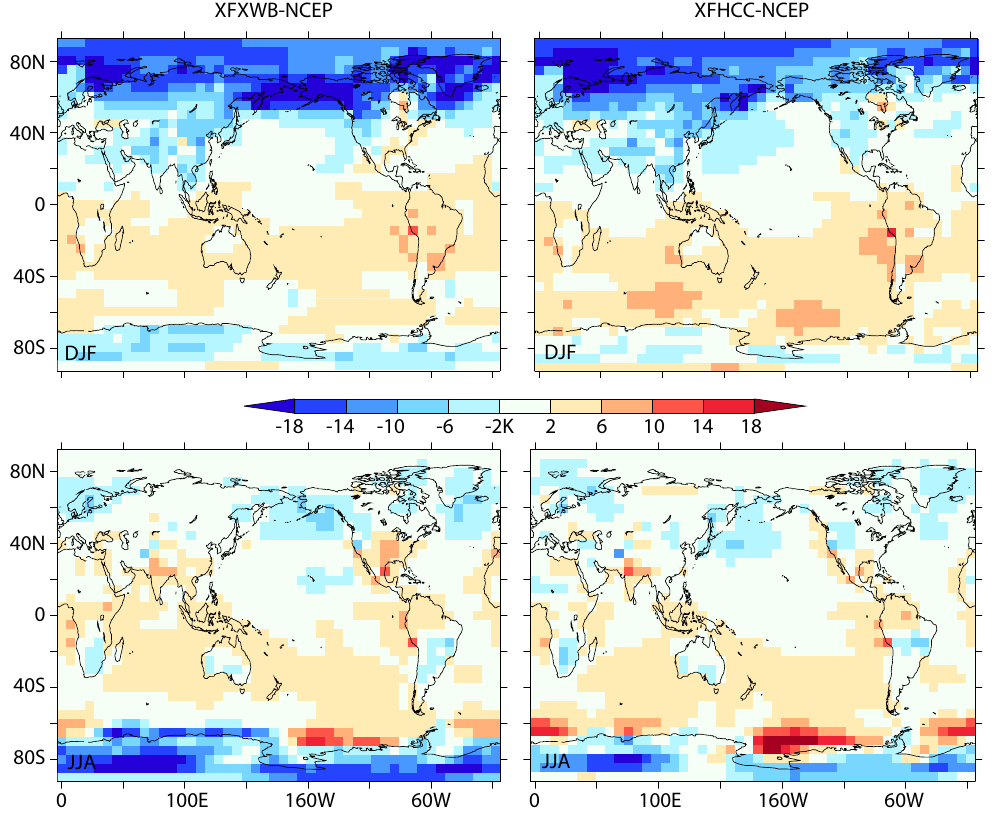
Fig. 2. Errors in seasonal surface temperature with respect to the NCEP reanalysis (Kalnay et al., 1996). Left: XFXWB-NCEP; right: XFHCC-NCEP; top: DJF; below: JJA.